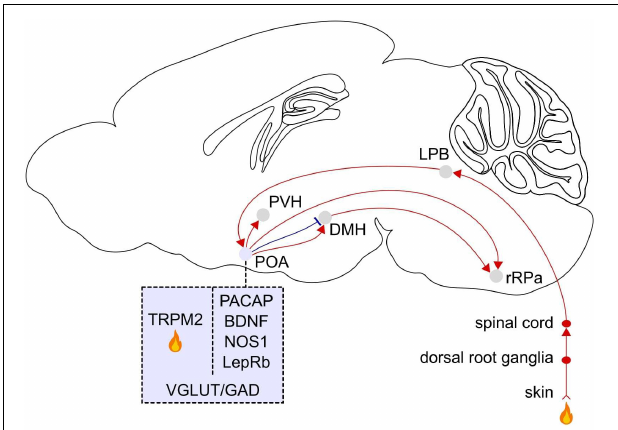
FIGURE 3 | Afferent and efferent projections of POA warm sensitive neurons. Temperature signals are detected in the skin by primary sensory ganglia and then transmitted to the dorsal horn of the spinal cord, the lateral parabrachial nucleus (LPB) in the pons, and the POA. Molecular markers for POA neurons that become activated in response to external warming are pituitary adenylate cyclase-activating polypeptides (PACAP) and brain-derived neurotrophic factor (BDNF), neuronal nitric oxide synthase (NOS1), and the leptin receptor (LepRb). The transient receptor potential M2 (TRPM2) ion channel is a local heat sensor in the POA. Thermoregulatory neurons in the POA project to the dorsomedial hypothalamus (DMH) and rostral raphe pallidus (rRPa). The rRPa is also strongly innervated by the DMH. TRPM2 labeled POA neurons project to the paraventricular hypothalamus (PVH). POA neurons labeled with these markers co-express vesicular glutamate transporter (VGLUT) or glutamic acid decarboxylase (GAD). Sagittal brain scheme adapted from Allen Mouse Brain Atlas (©Allen Brain Atlas API. Available from